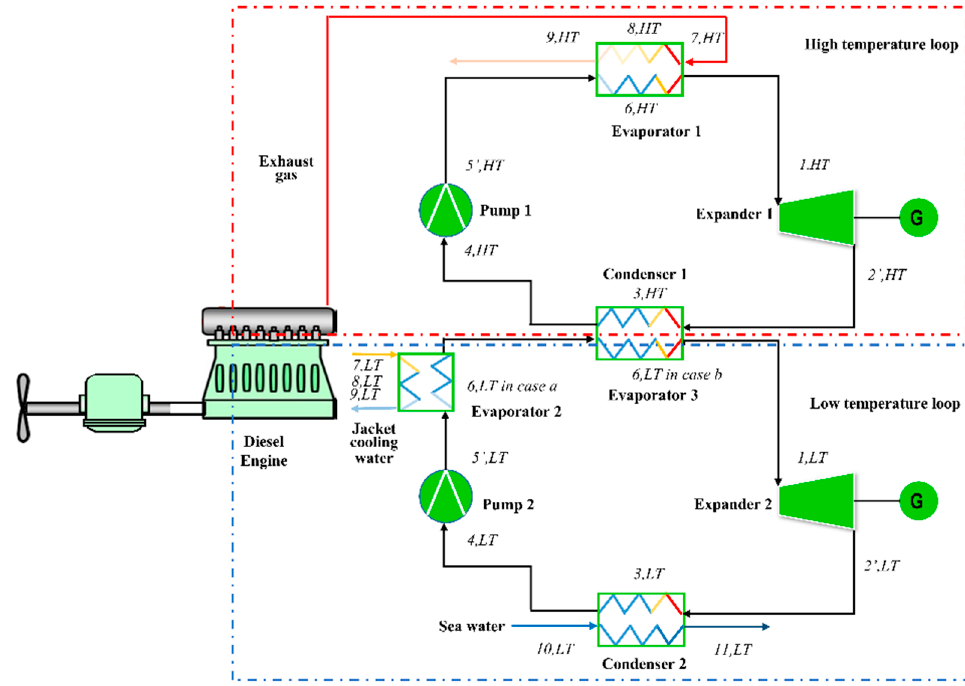
Figure 3. Schematic diagram of a dual-loop ORC.